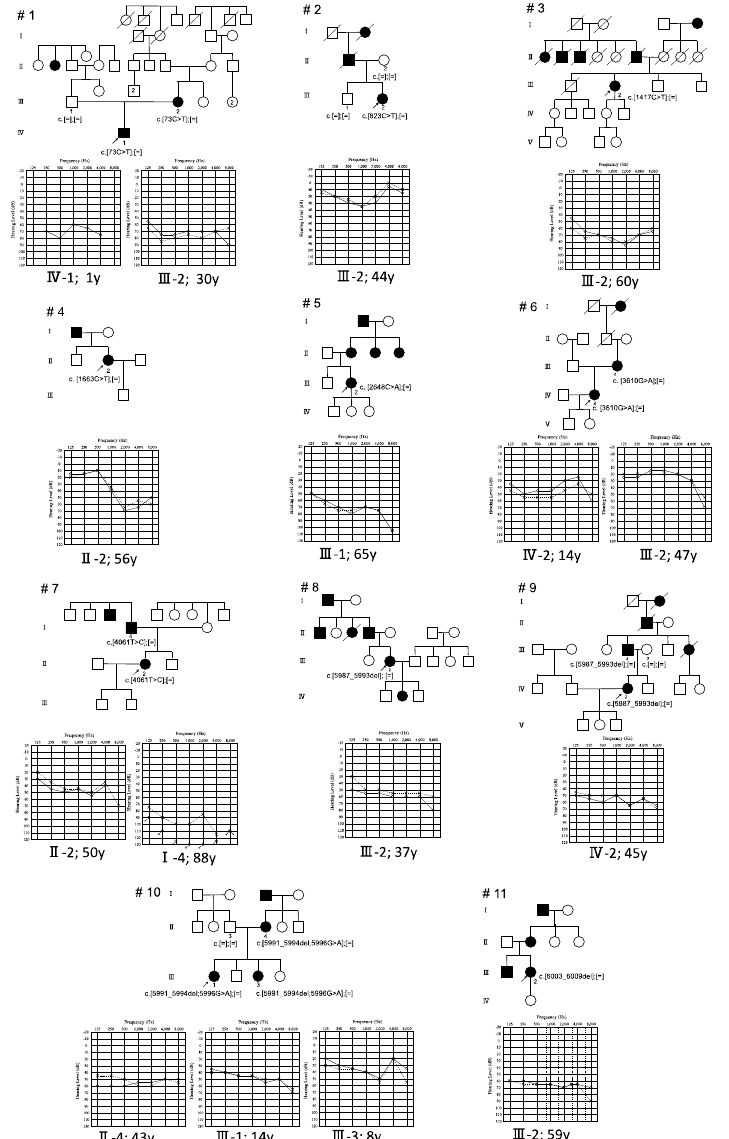
Figure 1. Pedigree, identified variants, and audiograms for the MYH14 -associated hearing-loss patients identified in this study. Arrowheads indicate the proband for each family. Identified variants are indicated on the pedigree. Audiograms for the proband and other affected family members are shown with the age at hearing testing.